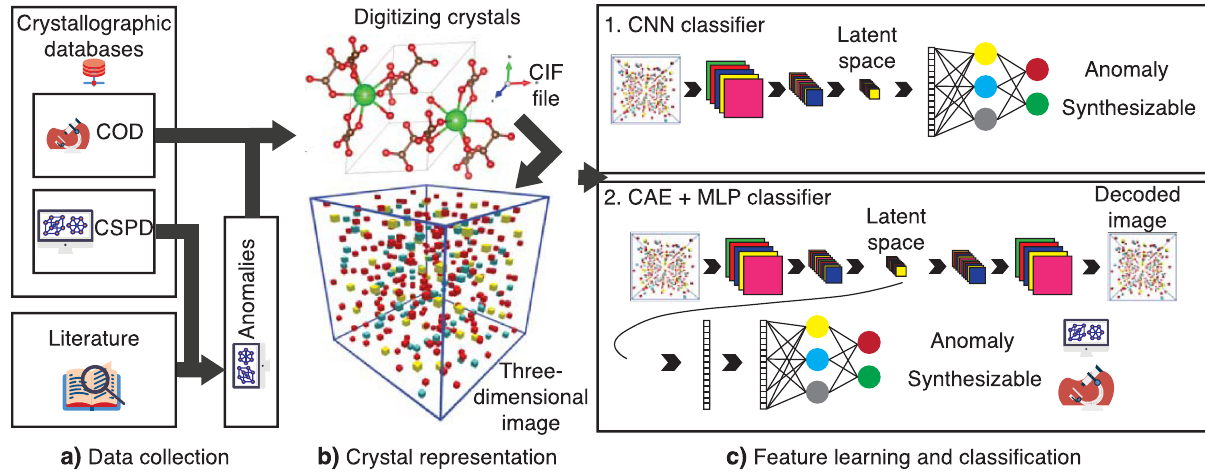
Fig. 1 The overall framework of the synthesizability likelihood prediction model. a Crystal samples for the synthesizable class are obtained from the Crystallographic Open Database (COD). We prepare crystal anomaly samples by using the crystal structure prototype database (CSPD) to generate crystal structures for the most-studied compositions in the published literature that are absent in the COD. b The crystal information fi les (CIFs) (extracted from the COD or generated by the CSPD) are converted into digitized three-dimensional images, which are used as the inputs for the convolutional encoder or convolutional auto-encoder. c Supervised and unsupervised feature encoding of three-dimensional images are performed using a convolution encoder followed by a multi-layer perceptron (MLP) classi fi er, referred to as the CNN classi fi er, and a convolutional auto-encoder (CAE), respectively. The unsupervised latent space representation of crystals from the auto-encoder is used as the input in an MLP classi fi er, referred to as the CAE + MLP classi fi